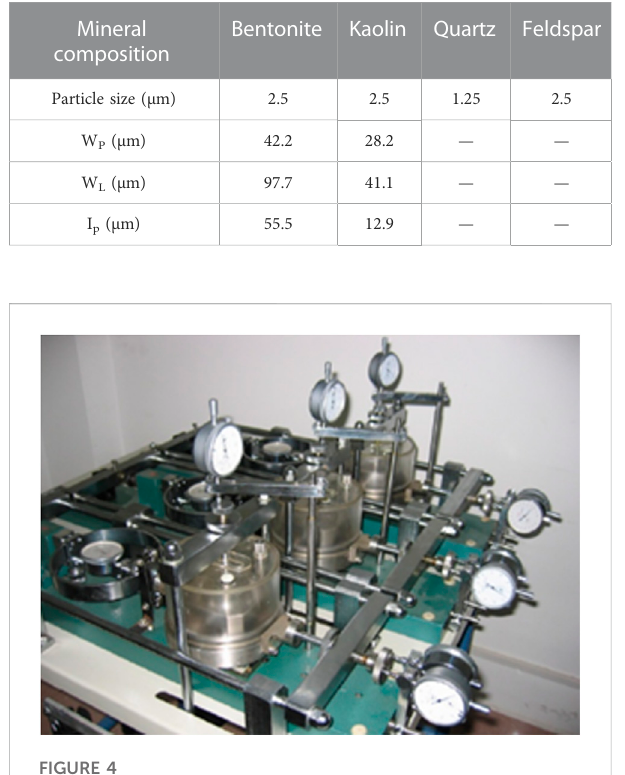
FIGURE 4 Physical picture of the improved direct shear creep apparatus.